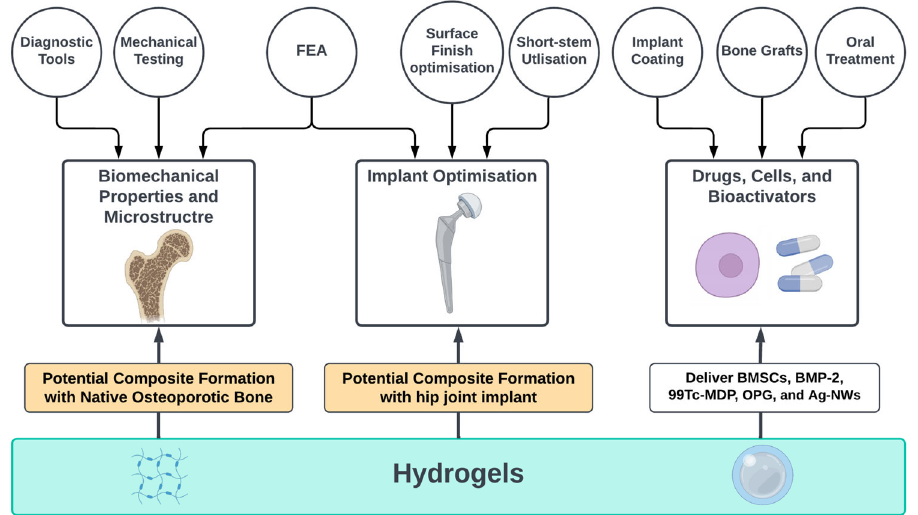
Figure 1. Overview of the review highlighting the importance of osteoporotic bone biomechanics, im- plant optimisation and drug delivery systems, created with BioRender.com (accessed on 9 January